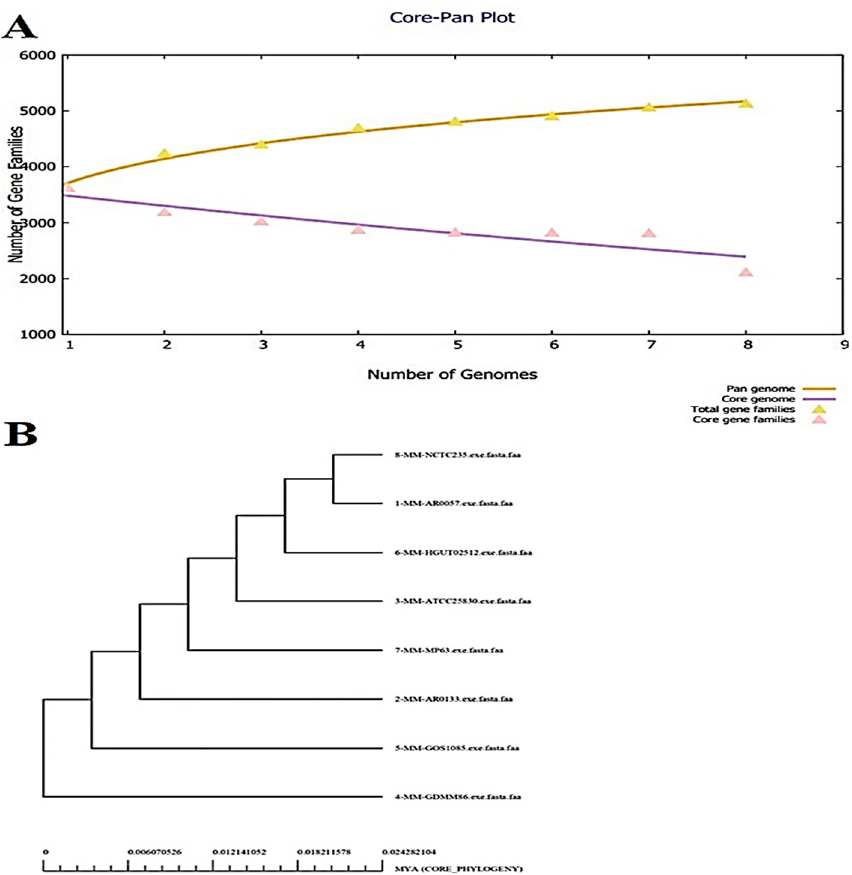
Figure 2. ( A ) Pan Core plot of 8 M. morganii genomes. ( B ) Pan-phylogeny tree of 8 complete genomes of M. morganii .